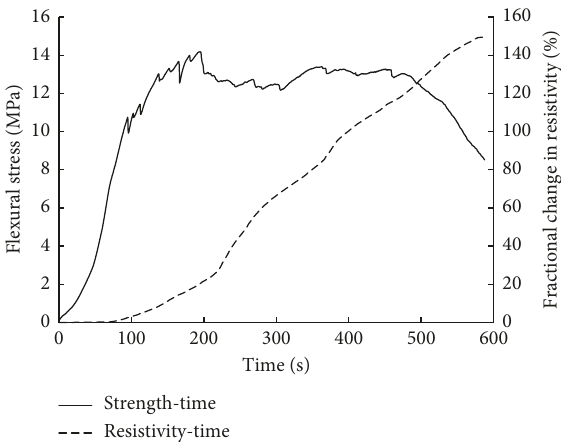
Figure 9: Self-sensing behavior of MWCNT-reinforced ECCs subjected to multiple-stage loading.